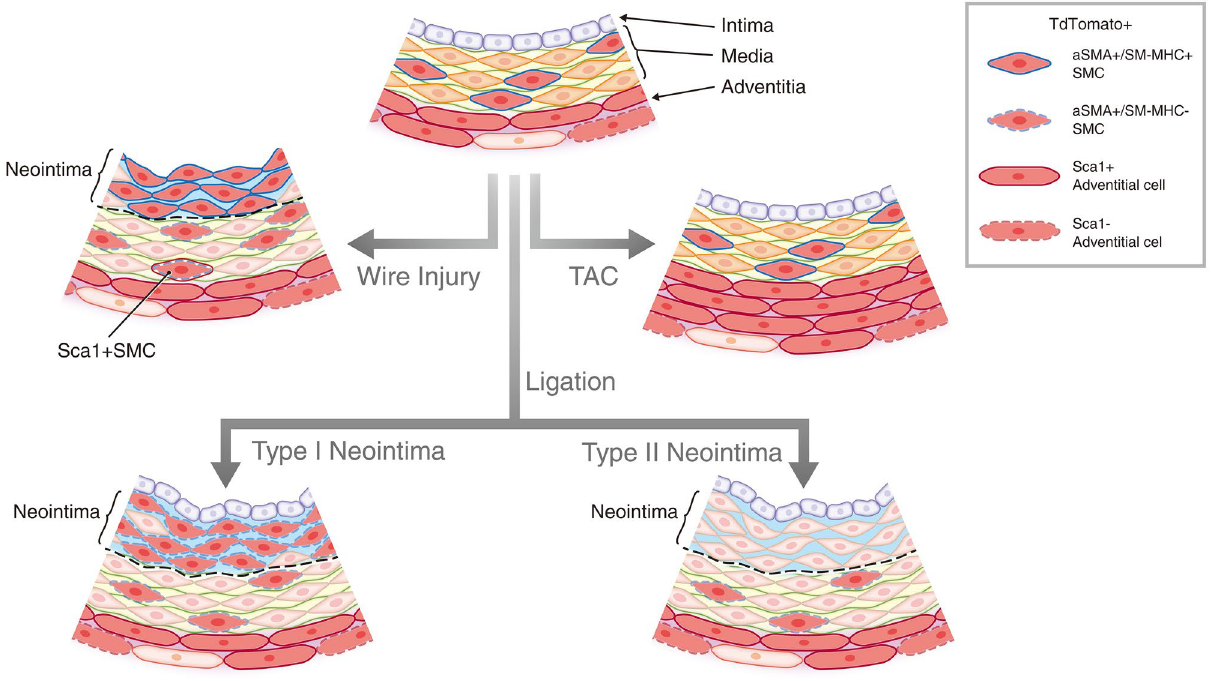
Figure 7. Cellular dynamics of PDGFRa+ cells in response to injuries. Schematic outline of the distinct cellular dynamics of PDGFRa+ cells (red) in response to injuries. The cell populations in the neointima induced by ligation and denudation injuries are heterogeneous and physical insults elicited distinct responses from SMCs that originated from PDGFRa+ cells. In wire injury, adventitial PDGFR+ cells migrated to the media and their daughter cells contributed to neointima formation. Note that tdTomato+ Sca1+ SMC is detected in the medial layer only after wire injury. (CC BY Mayumi